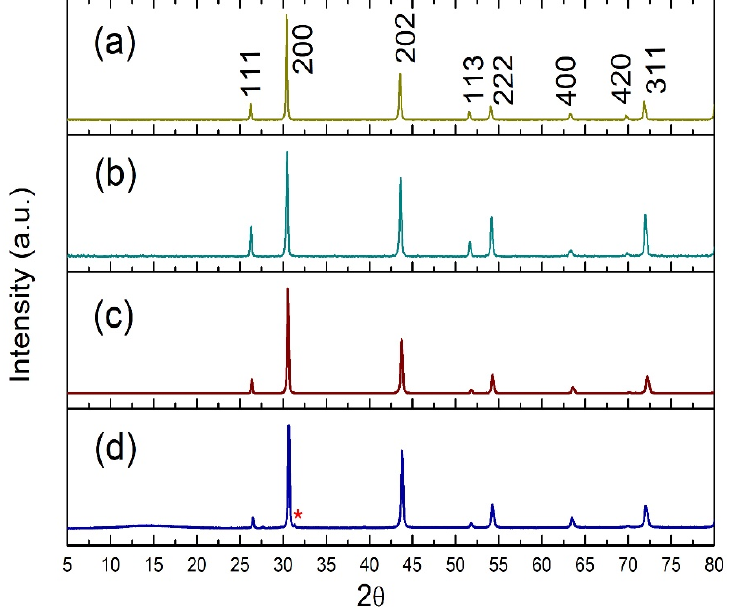
Figure 2. Representative powder XRD patterns at room temperature of: ( a ) AgSnBiSe 3 showing the corresponding hkl miller indices, ( b ) AgSn[Bi 0.8 Sb 0.2 ]Se 3 , ( c ) AgSn[Bi 0.2 Sb 0.8 ]Se 3 , and ( d ) AgSn 2 [Bi 0.2 Sb 0.8 ]Se 4 (the red asterisk indicates a secondary reflection indexed to the SnSe Pnma space group).